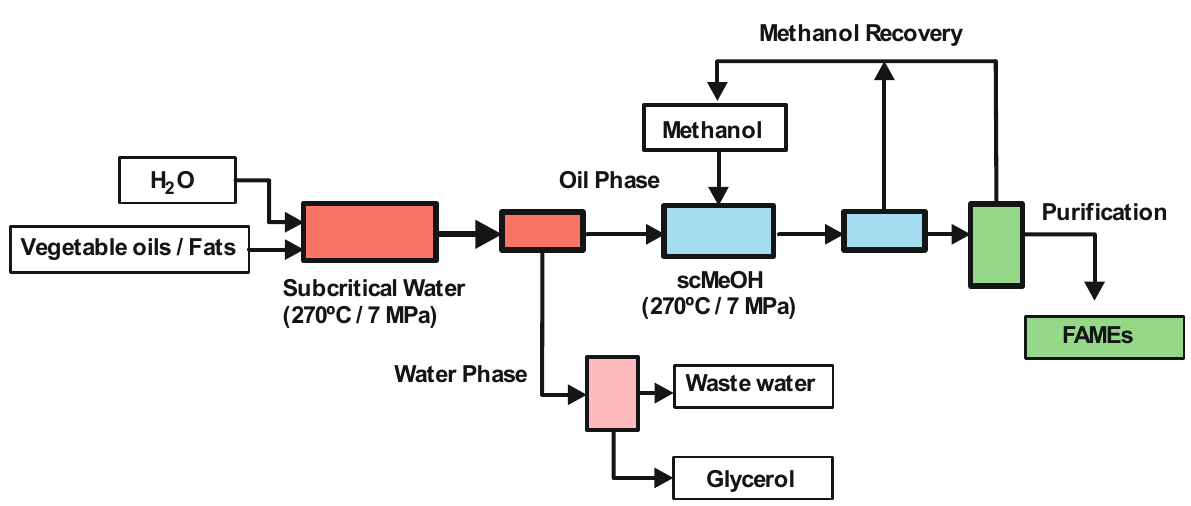
Figure 5. Biodiesel synthesis by the Saka-Dadan two-step supercritical method